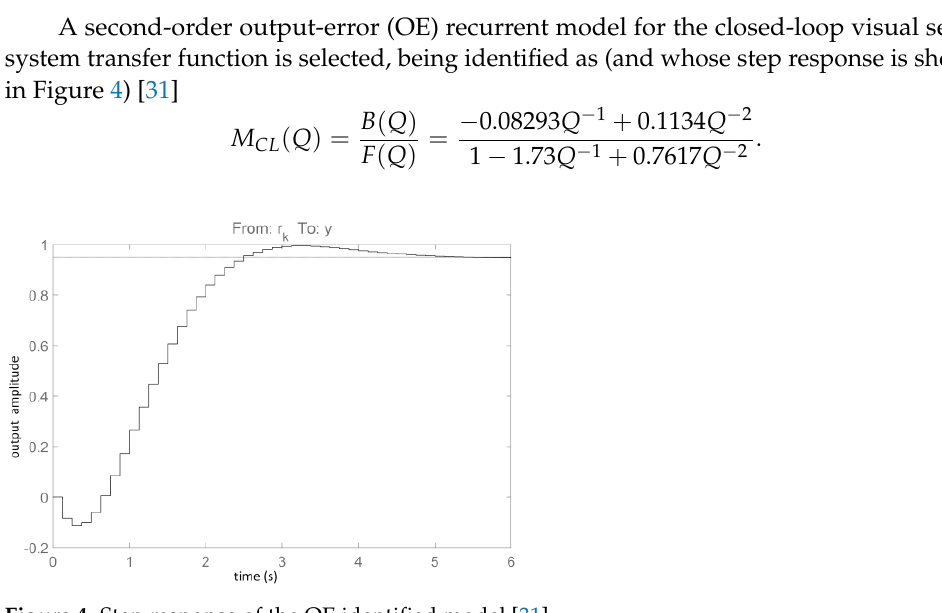
Figure 3. Data used for validating the identified closed-loop visual servo system model ( ρ k -red, y k -black).